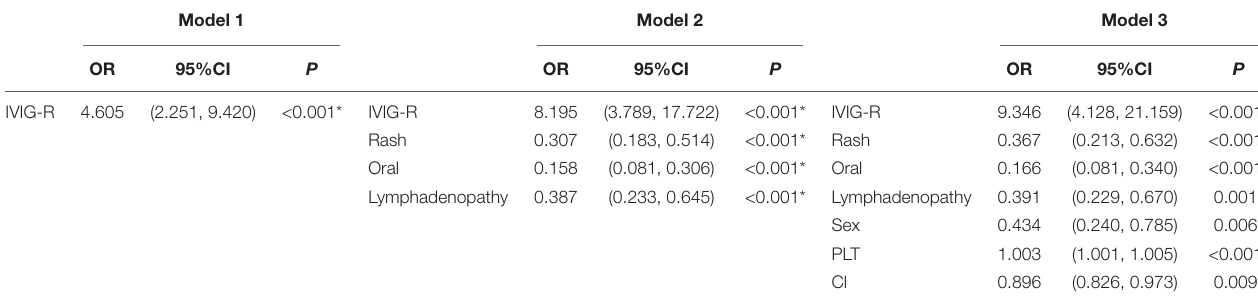
TABLE 3 | Logistic regression analysis of three models for better predicting CAA.